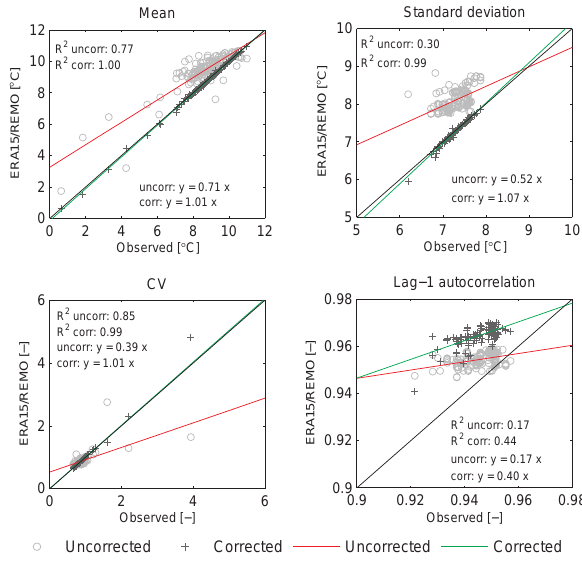
Fig. 12. Scatter plots of the statistics of the observed tempera- ture versus the corrected and uncorrected ERA15/REMO tempera- ture. The statistics are calculated for each sub-basin over the period 1979–1995. In each subplot the square of the correlation coefficient ( R 2 ) and slope of the linear regression line are plotted. The black line represents the x = y